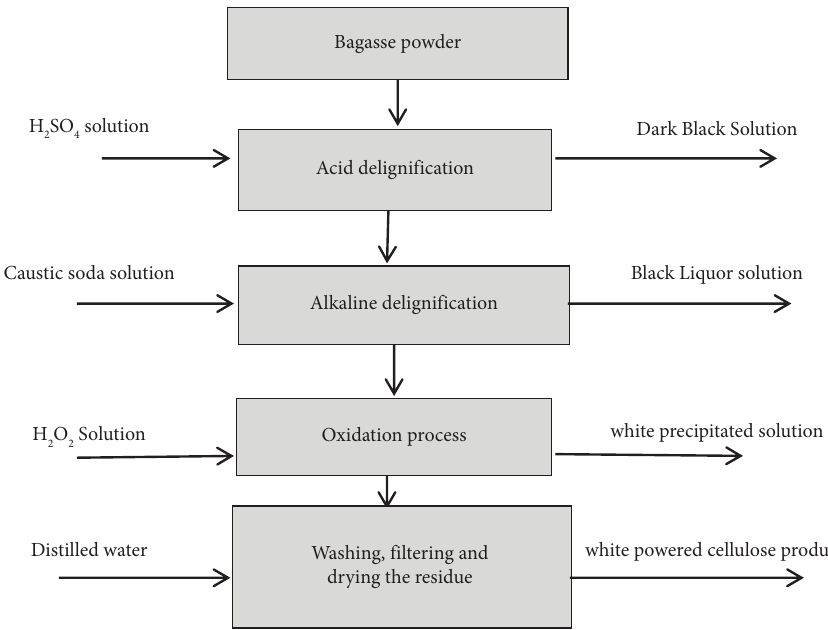
Figure 1: Flow sheet for extraction of cellulose from sugar cane